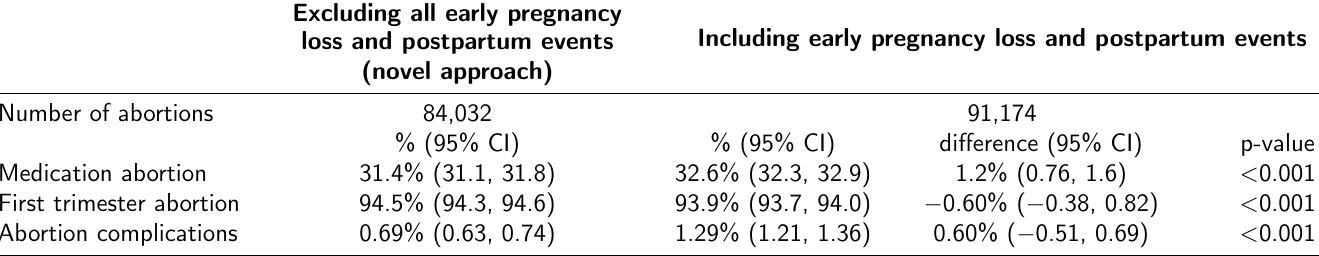
Table 1: Impact of excluding vs. including early pregnancy loss and postpartum events (Principle 1) to define abortion cohorts on the number and characteristics of abortions identified